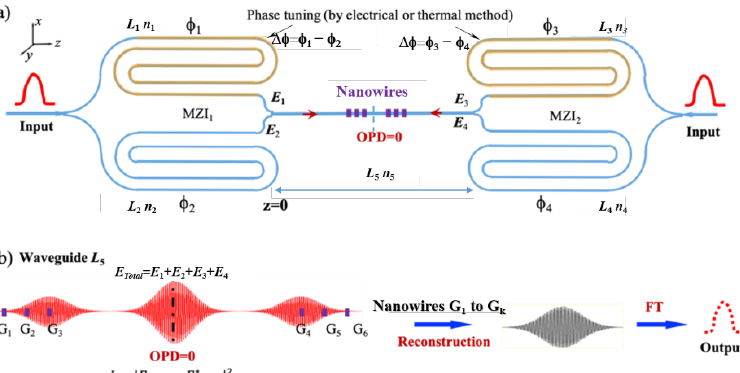
Figure 1. ( a ) Schematic diagram of the DTM-SWIFT system. ( b ) Sampling and reconstruction process. The upper arm lengths of MZI 1 and MZI 2 are L 1 and L 3 , and the lower arm lengths are L 2 = L 1 + ∆ L and L 4 = L 3 + ∆ L , and the corresponding refractive index is n 1 , n 2 , n 3 and n 4 . The length of the straight waveguide in the middle is L 5 , and the corresponding refractive index is n 5 . ∆ L is an initial arm length difference between two arms of each MZI, which is determined by an initial phase.